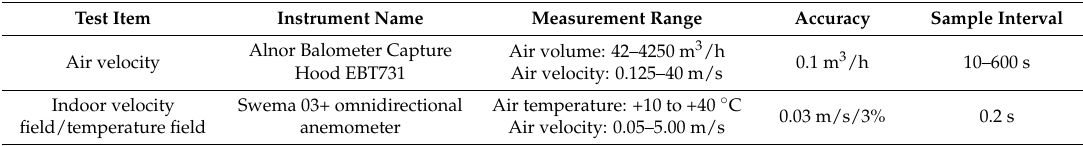
Table 1. Test items and